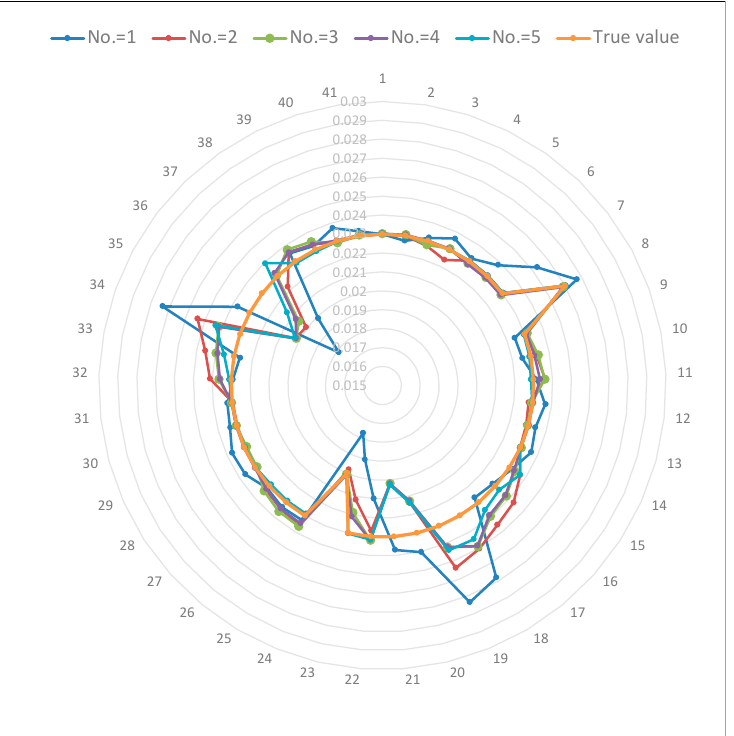
Figure 5. Impact of the number of measurement stations on inversed roughness values at river segments 1 to 41.